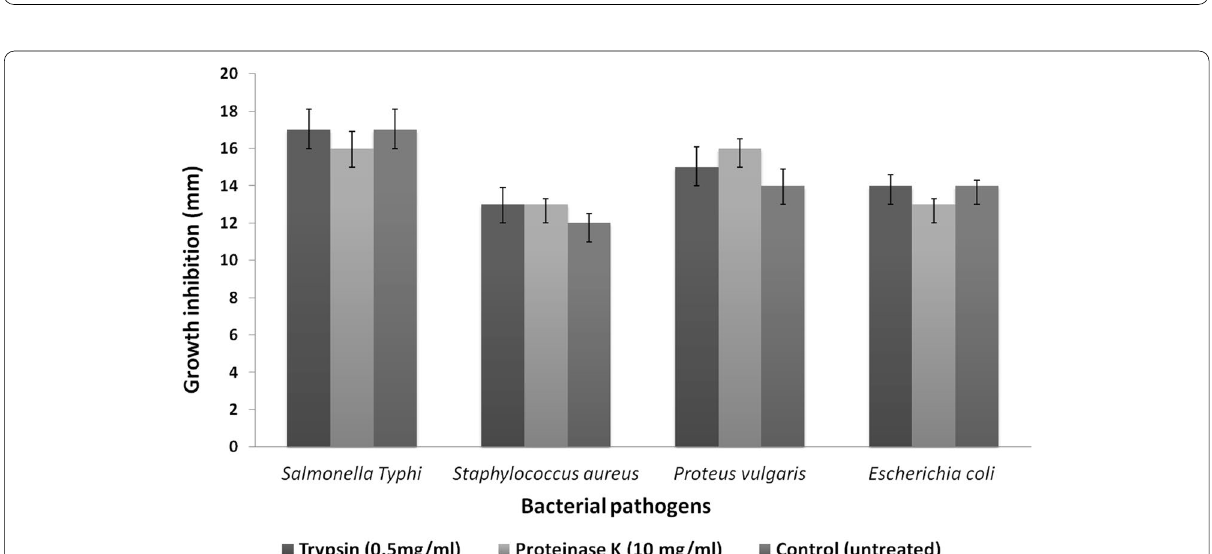
Fig. 7 Antimicrobial activity of JB140 Sa,St,Pv against Salmonella Typhi, Staphylococcus aureus , Proteus vulgaris , and a clinical MDR uropathogenic Escherichia coli isolate after treatment with 0.5 mg/ml trypsin and 10 mg/ml proteinase K. Values represent the mean